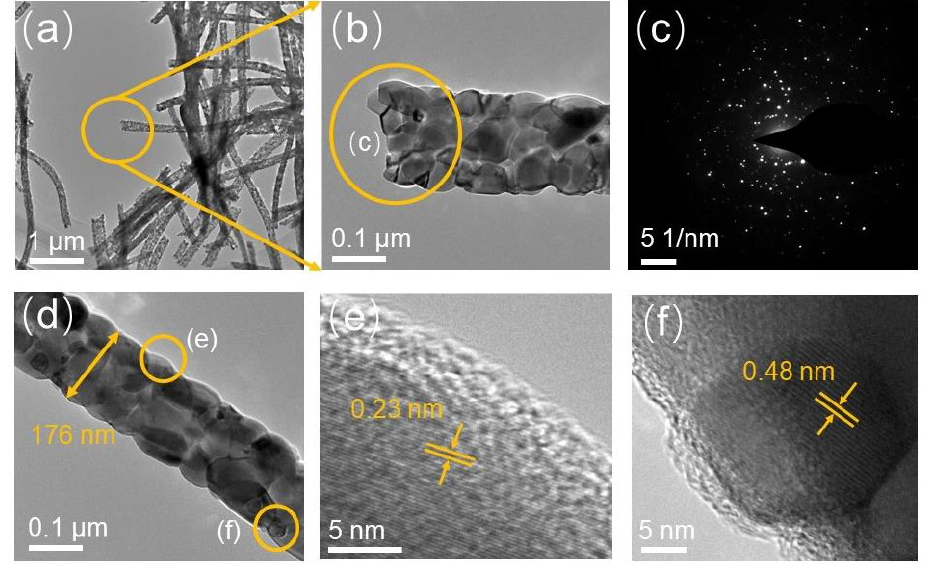
Figure 5. ( a, b, d ) TEM images of NiO/NiTiO 3 composite fibers calcined at 800 °C, ( c ) selected area Figure 5. ( a , b , d ) TEM images of NiO / NiTiO 3 composite fibers calcined at 800 ◦ C, ( c ) selected area electron diffraction in (b), and ( e, f ) high-resolution TEM images. electron di ff raction in (b), and ( e , f ) high-resolution TEM